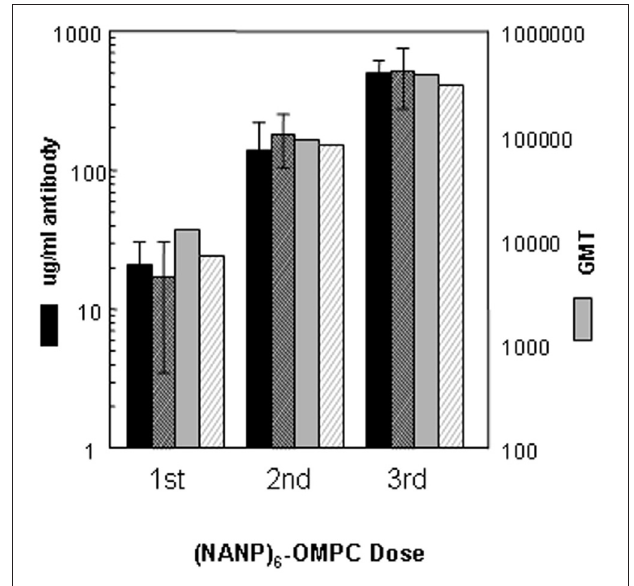
FIGURE 1 | Immunogenicity of (NANP) 6 -OMPC in BALB/c. Mice ( n = 10/group) were immunized with three doses of (NANP) 6 -OMPC/MAA with (open bars) or without (hatched bars) Iscomatrix®. ELISA used either recombinant protein R32 (left panel), or (NANP) 3 peptide (right panel). Antibody levels obtained with freshly prepared (NANP) 6 -OMPC/MAA (hatched bars) were compared with peptide-conjugate stored for 2 years at 4 ◦ C (black bars).